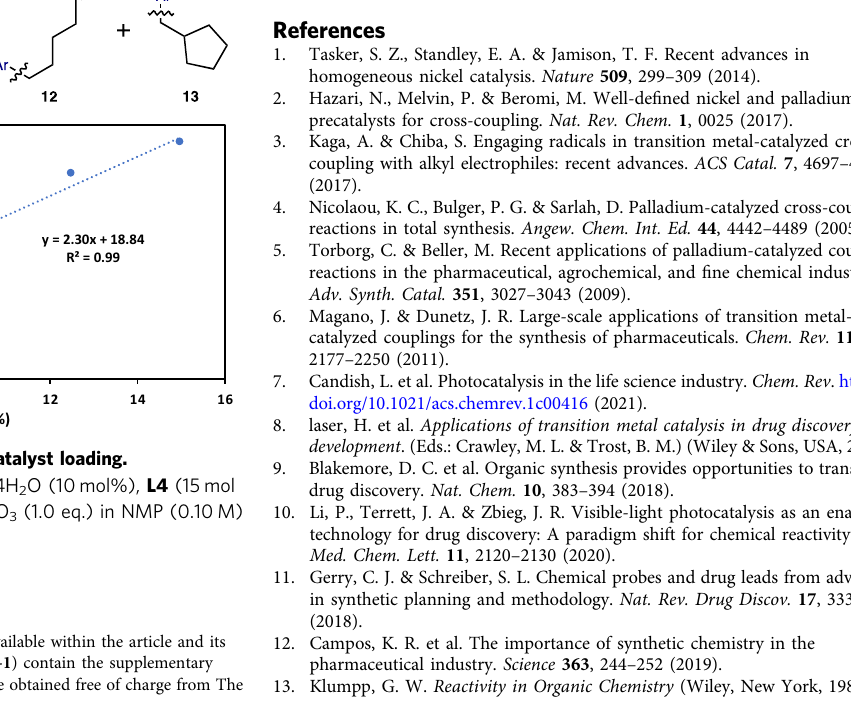
Data availability The data supporting the fi ndings of this study are available within the article and its Supplementary Information fi le. CCDC 2102869 ( Ni-1 ) contain the supplementary crystallographic data for this paper. These data can be obtained free of charge from The